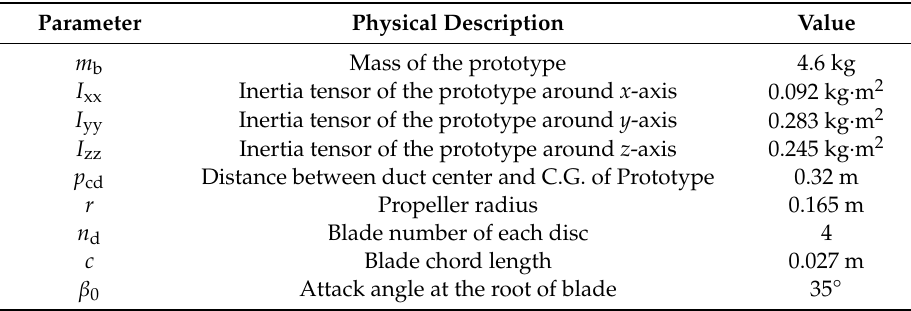
Figure 2. Novel prototype with manipulation. Table 1. Structural parameters of the prototype.